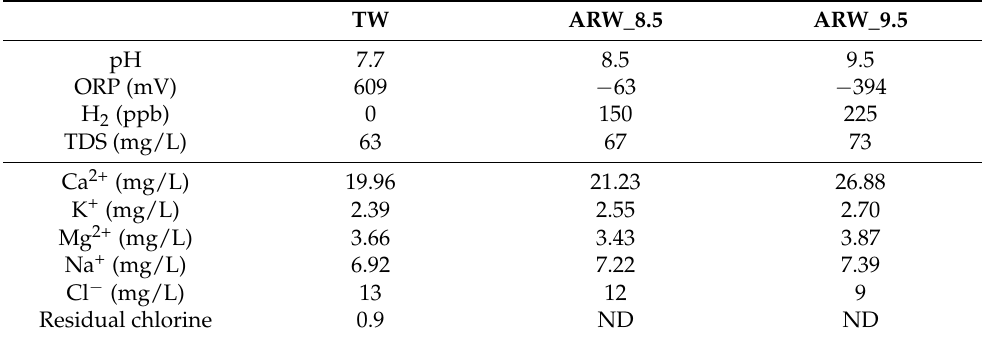
Table 1. Major water physical and chemical components of tap water and alkaline reduced water.